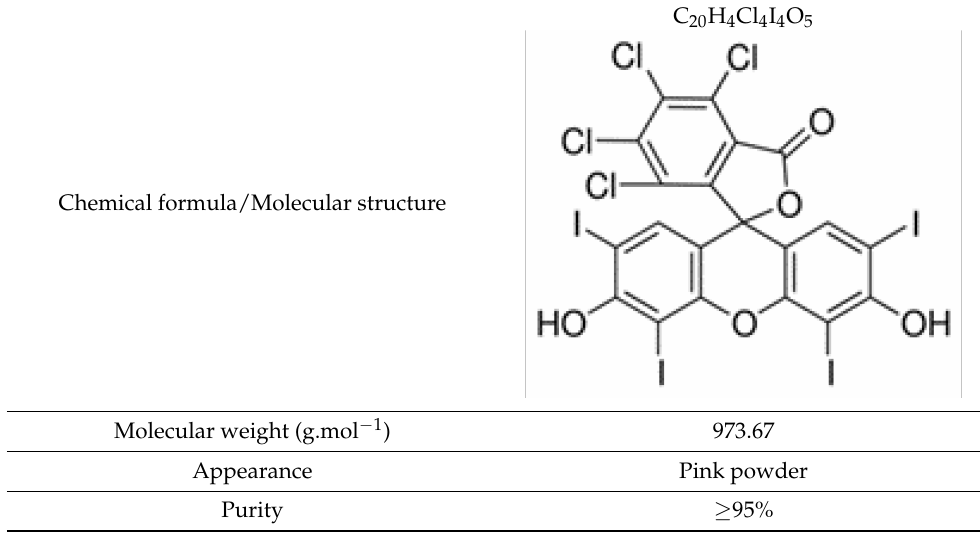
Chemical formula/Molecular